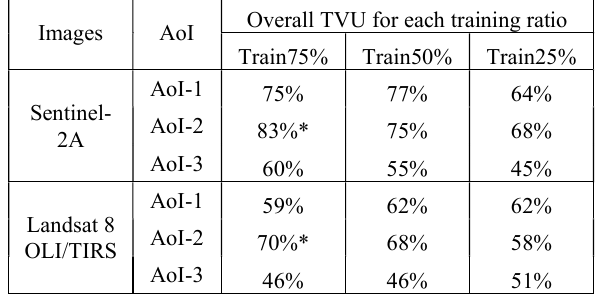
Table 3. The overall TVU values for each training ratio; the asterisk symbols present the highest TVU values for each image.